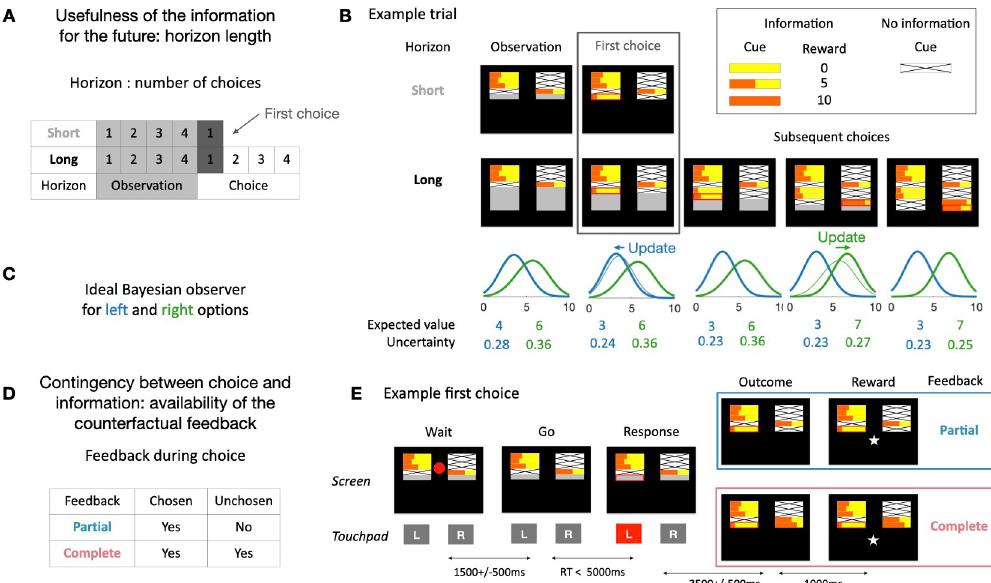
Fig 1. Task and model. ( A ) During the task, we manipulated whether the information could be used in the future by including both long and short horizon sequences. In both trial types, monkeys initially received four samples (“observations”) from the unknown underlying reward distributions. In short horizon trials, they then made a one-off decision between the two options presented on screen (“choice”). In long horizon trials, they could make four consecutive choices between the two options (fixed reward distributions). On the first choice (highlighted), the information content was equivalent between short and long horizon trials (same number of observations), whereas the information context was different (learning and updating is only beneficial in the long horizon trials). ( B ) Example short and long horizon trials. The monkeys first received some information about the reward distributions associated with choosing the left and right option. The length of the orange bar indicates the number of drops of juice they could have received (0–10 drops). The horizon length of the trial is indicated by the size of the grey area below the four initial samples. The monkeys then make one (short horizon) or four (long horizon) subsequent choices. As monkeys progressed through the four choices, more information about the distributions was revealed. Displayed here is a partial information trial where only information about the chosen option is revealed. ( C ) Ideal model observer for the options of the example trial shown in B (color code corresponds to the side of the option). The distributions correspond to the probabilities to observe the next outcome for each option. The expected value corresponds to the peak of the distribution and the uncertainty to the variance. Thick lines correspond to post-outcome estimate and thin lines to pre- outcome estimates (from the previous trial). ( D ) We also modulated the contingency between choice and information by including different feedback conditions. In the partial feedback condition, monkeys only receive feedback for the chosen option. In contrast, in the complete feedback condition, they receive feedback about both options after active choices (not in the observation phase). ( E ) Example partial and complete feedback trials (both short horizon). Here, the observation phase shown in (B) is broken up into the components the monkeys see on screen during the experiment. Initially, the samples were displayed on screen, but a red circle in the center indicates that the monkeys could not yet respond. After a delay, the circle disappears, and the monkeys could choose an option. After they responded, the chosen side was highlighted (red outline). After another delay, the outcome was revealed. In the partial feedback condition (top), only the outcome for the chosen option was revealed. In contrast, in the complete feedback condition (bottom), both outcomes were revealed. After another delay, the reward for the chosen option was delivered in both